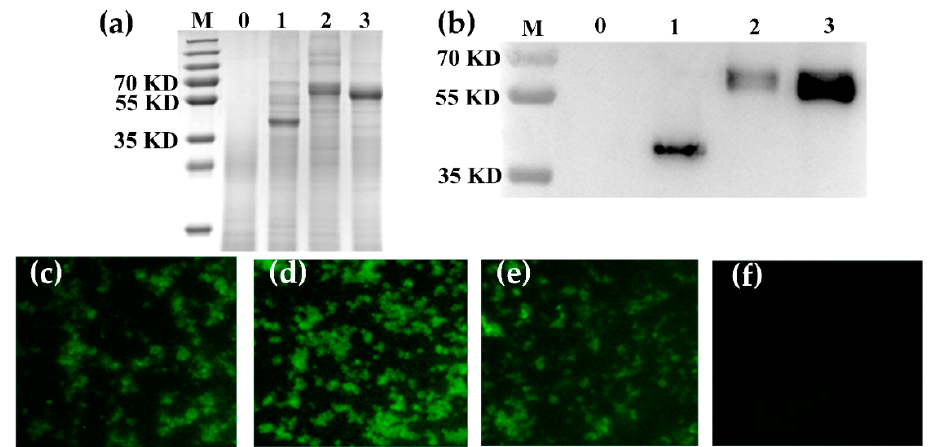
Figure 2. Detection of the fusion proteins displaying the GEM particles. ( a ) SDS-PAGE analysis of the displaying of RLP 2 , RLP 3 , and RP 3 proteins on GEM particles. Lane 1: GEM particles displaying RLP 2 from the culture supernatant of rBV-RLP 2 -infected Sf9 cells; Lane 2: GEM particles displaying RLP 3 from the culture supernatant of rBV-RLP 3 -infected Sf9 cells; Lane 3: GEM particles displaying RP 3 from the culture supernatant of rBV-RP 3 -infected Sf9 cells; Lane 0: GEM particles; M: molecular weight marker. ( b ) Western blot analysis of the proteins displayed on GEM particles. Lane 1, Lane 2, Lane 3, and Lane 0 are the same as in Figure 2a. ( c – f ) Representative fluorescence microscopy images showing that fusion proteins were loaded on GEM particles (Magnification of microscopy images, 1000 × ). GEM particles were bound with RLP 2 ( c ), RLP 3 ( d ), and RP 3 ( e ) proteins and were the mock control ( f ); proteins were detected with a rabbit anti-MERS-S polyclonal antibody.